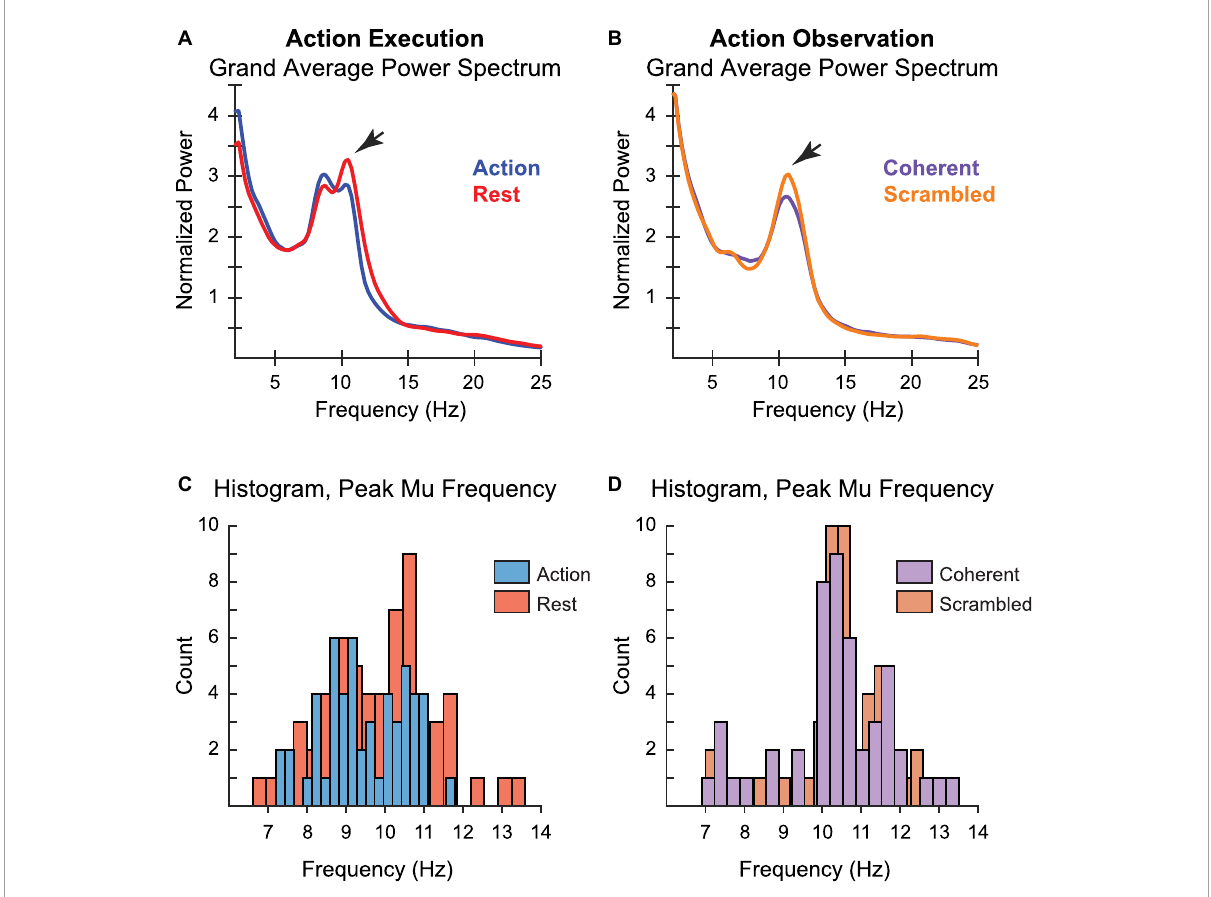
FIGURE3 Peak mu frequency for action execution (left) and action observation (right). Grand average power spectrum for (A) action execution, action (blue) vs. rest (red), and (B) action observation, coherent (purple) vs. scrambled (orange) movement. Histogram of individual measurements of peak mu frequency for (C) action execution, action (blue) vs. rest (red), and (D) action observation, coherent (purple) vs. scrambled (orange) movement. The varying width of the bars for each condition reflects the number of bins for the histogram, selected automatically via algorithm to best cover the range of values while revealing the shape of the underlying